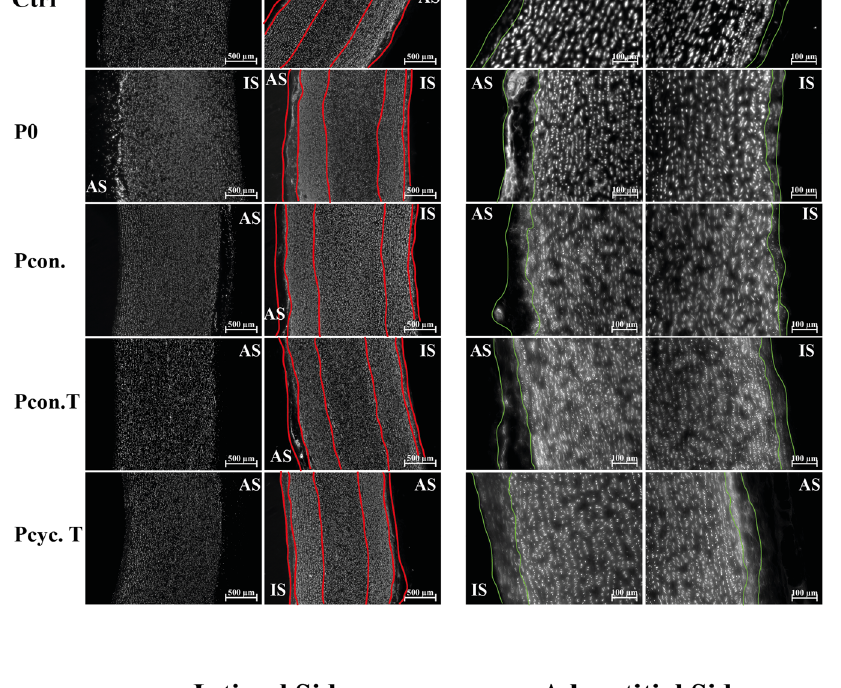
Fig. 4 H&E staining of decellularized as well as native aortic tissue. Representative images of H&E stained aortic tissue, either native or decellularized, are shown. Images were taken at a magni fi cation of ×20 (scale bar is 100 µm). Analysis of the images showed that none of the decellularization procedures resulted in impairment of the aortic structure. However, the loosening of the tissue in the areas of complete decellularization can be seen. This suggests that the endothelial cells and smooth muscle cells were completely removed in these areas. NA native tissue, DC decellularized tissue